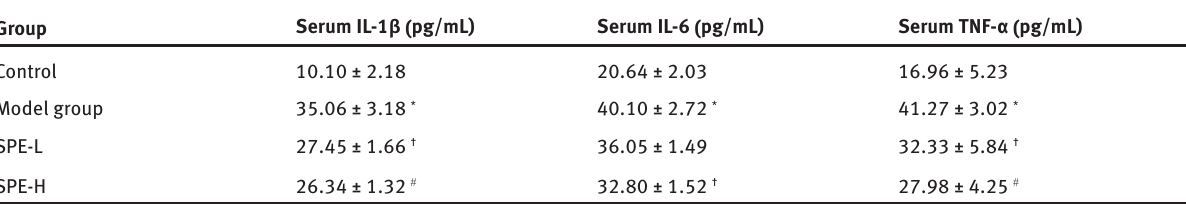
Table 4: Regulatory effects of SPE on serum IL-1β, IL-6 and TNF-α